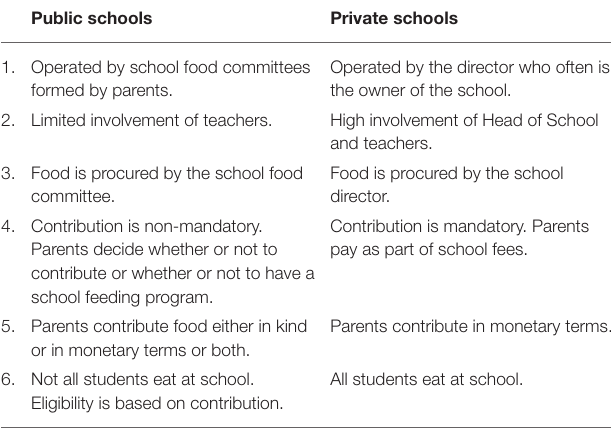
TABLE 2 | Public versus private school feeding